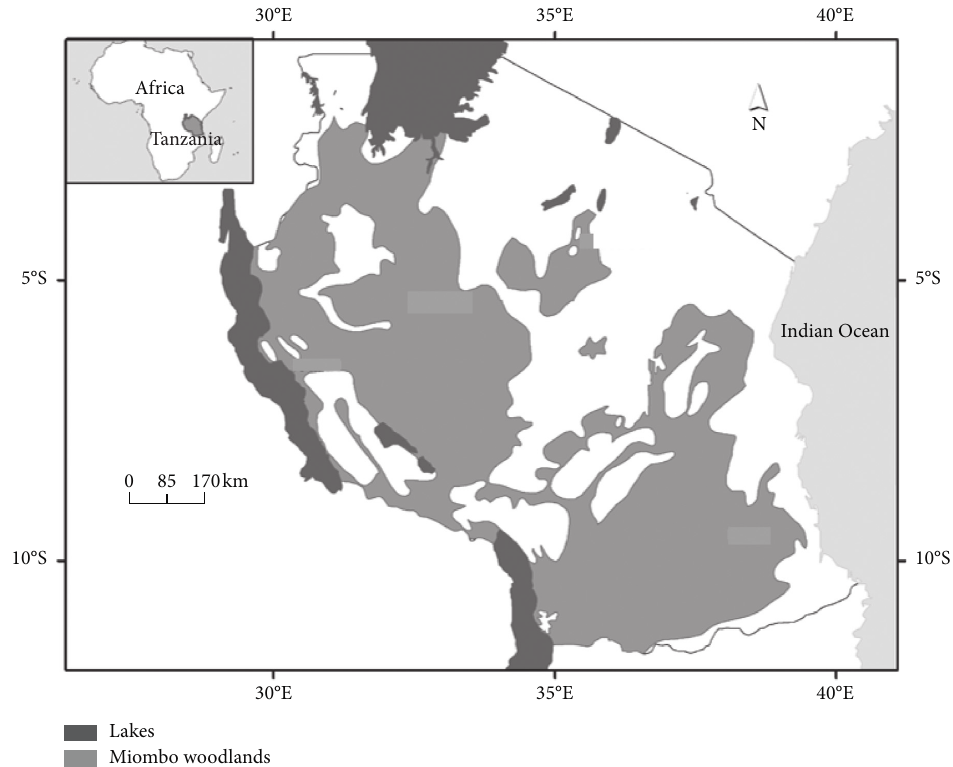
Figure 1: A map of Mainland Tanzania showing Miombo woodlands (modified from